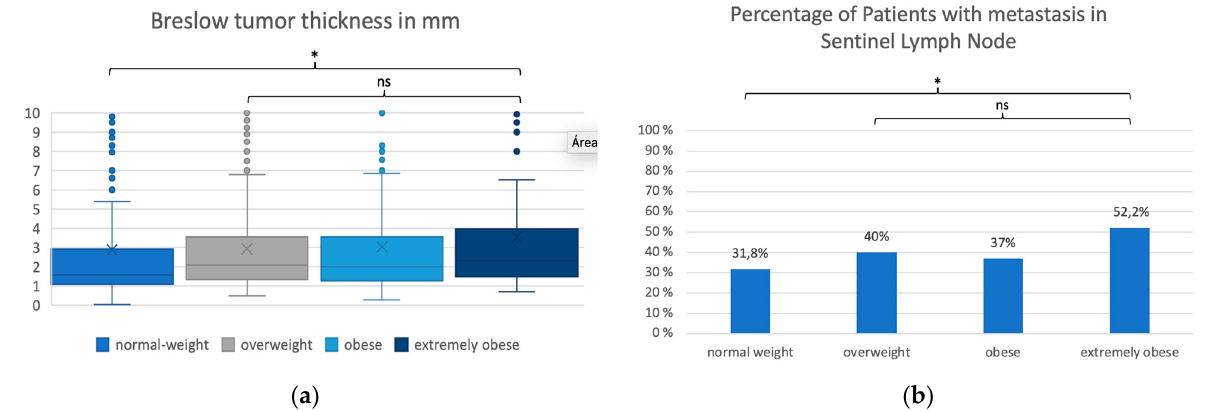
Figure 1. Comparison of BMI groups regarding Breslow tumor thickness ( a ) and metastases in sentinel lymph node ( b ). In ( a ), the y axis represents Breslow tumor thickness, and the x axis represents the different BMI groups. BMI groups: normal weight (BMI < 25), overweight (BMI >= 25 and <30), obese (BMI >= 30 and <35) and extremely obese (BMI >= 35). Breslow Tumor thickness was lower in normal weight patients (median 1.6 ± SD 5.9 mm) than in all patients with BMI >= 25 (respectively, 2.1 ± SD 2.5 mm, 2.0 ± SD 3.2 mm and 2.3 ± SD 3.2 mm) (* p < 0.001, p -Value Kruskal–Wallis test). Tumor thickness did not differ statically between the overweight and obese groups. In ( b ), the y axis represents percentage of patients in each group, and the x axis represents the different BMI groups. Sentinel lymph node was positive in 31.8% of normal-weight patients compared to 52.2% of extremely obese patients. (* p < 0.001, p -value Fisher’s test). ns = statistically non-significant.